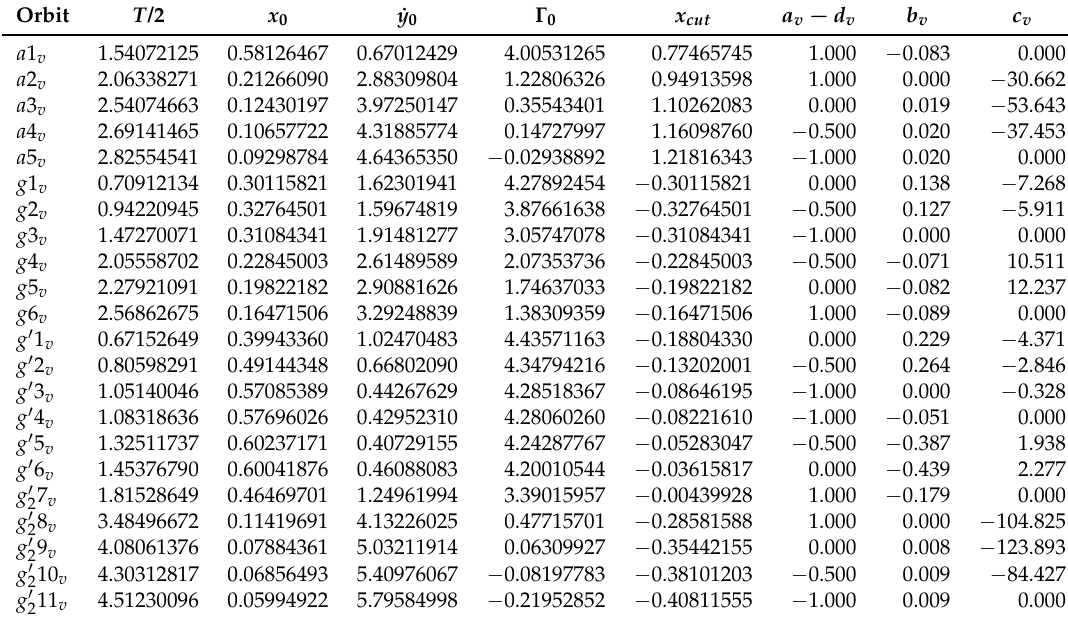
Table 1. VC and VSR orbits of families a , g and g (cid:48) . Due to the symmetry w.r.t. both axes the corresponding orbits of the Lyapunov family c emanating from the other equilibrium point L 1 are obtained directly from the Lyapunov family a ; so, they are not given